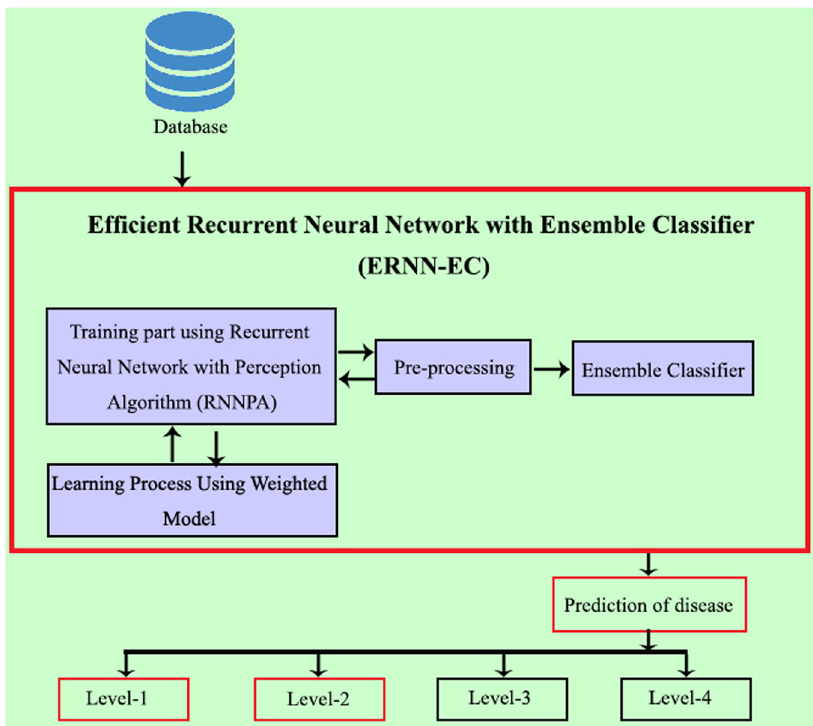
Figure 1: System architecture for neural network - based disease